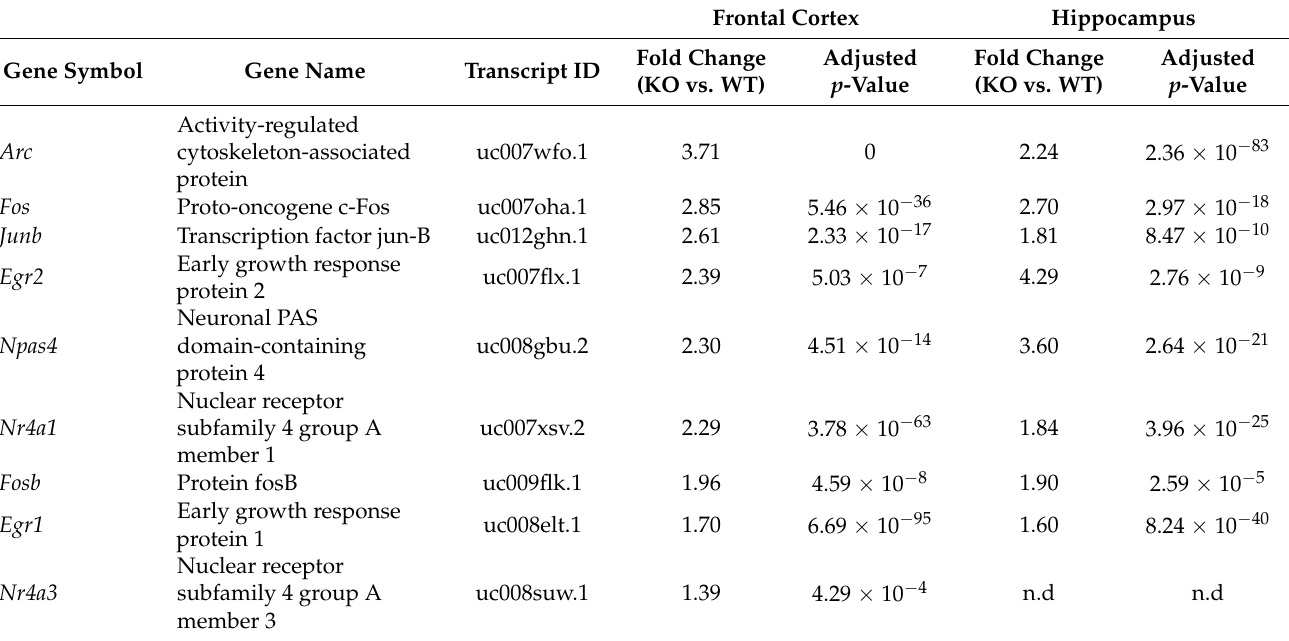
Table 1. IEGs transcriptional changes in prefrontal cortex and hippocampus of Mecp2 y/ − mice. n.d = not differentially